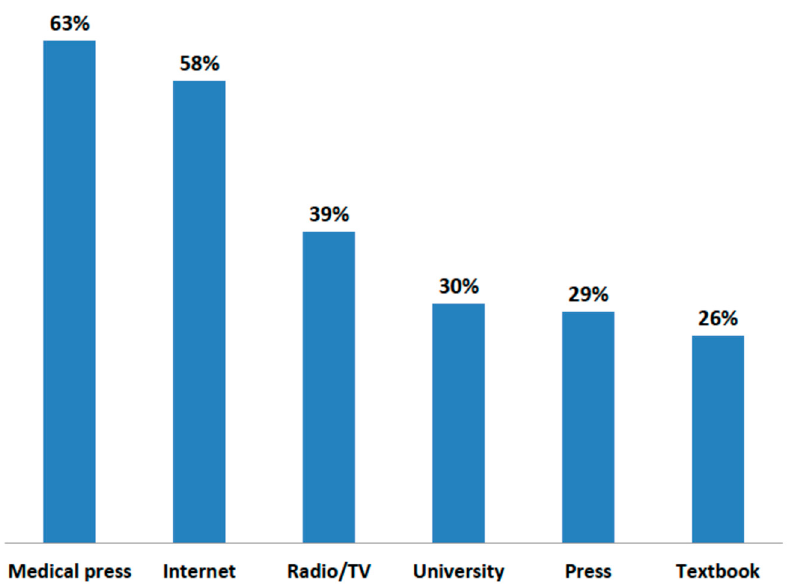
Figure 3. Main sources of pulmonologists’ knowledge about the impact of air pollution on health.